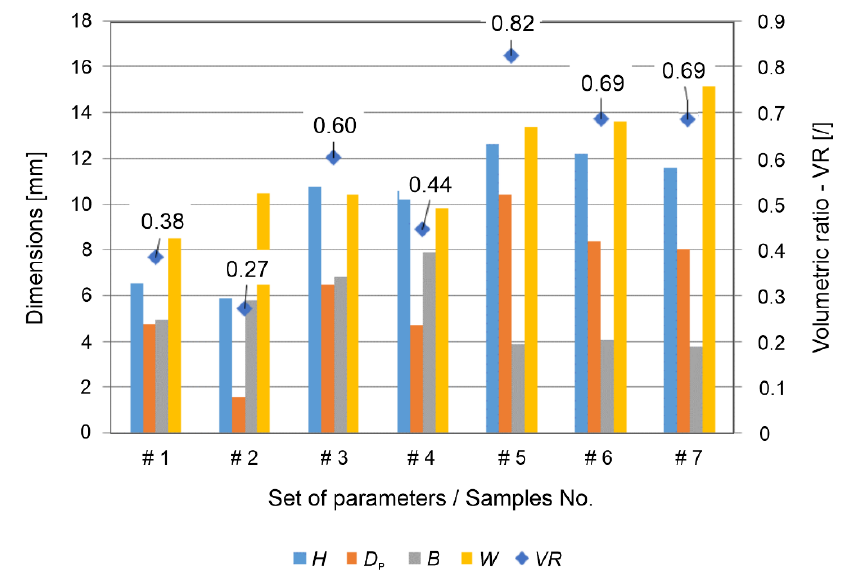
Figure 6. Rivet dimensions obtained from X-ray images according to Figure 1 and volume ratio ( VR ) calculated using Equation (3).